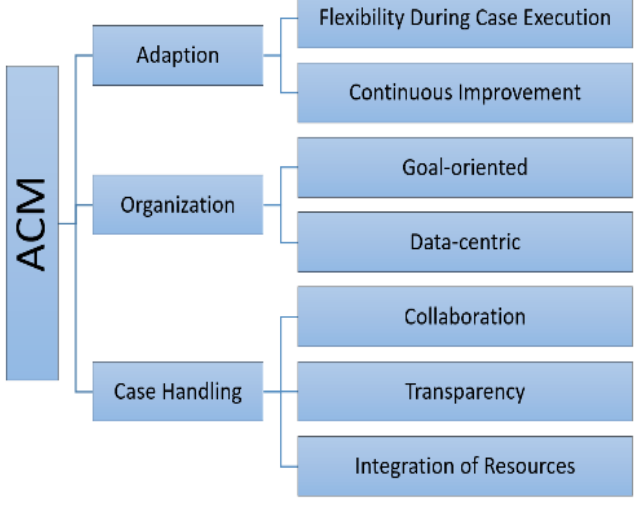
Figure 1. Central ACM Principles, adapted from